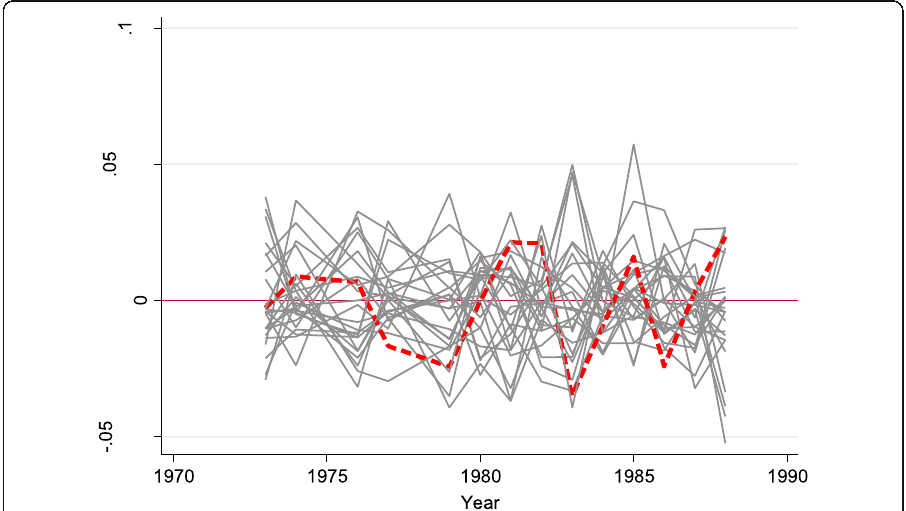
Fig. 2 Placebo test: Estimated fertility impacts for Miami and placebo fertility impacts for 26